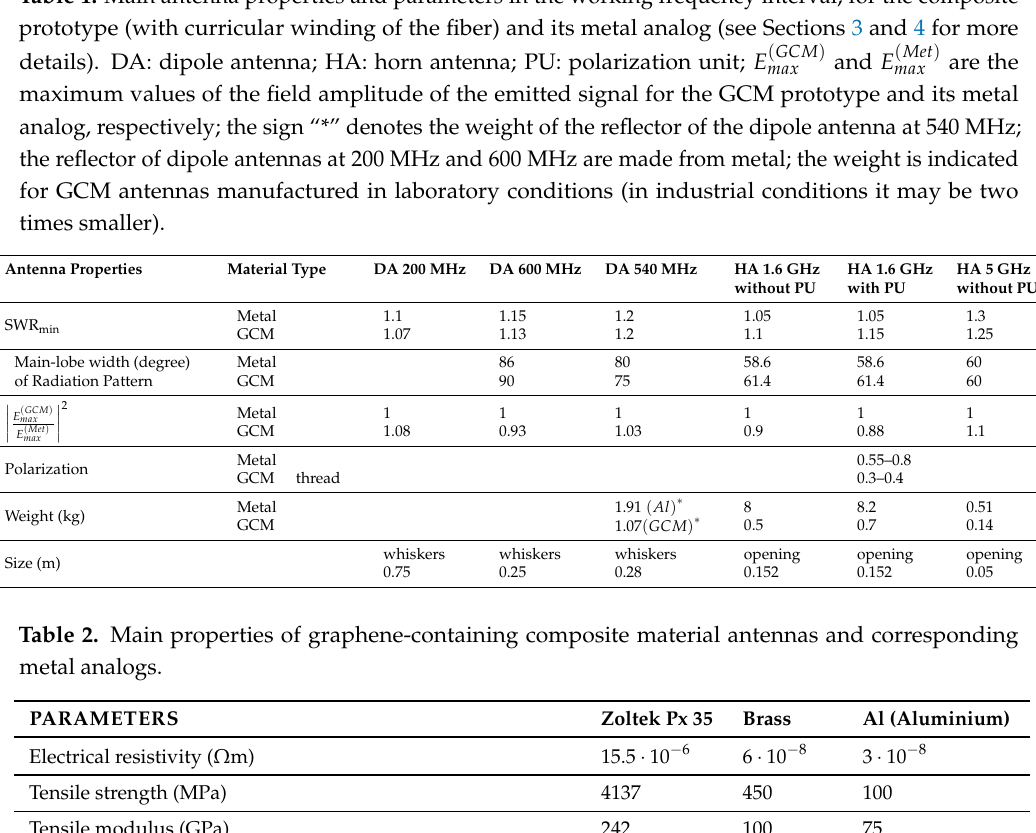
( GCM ) ( Met ) max and E max are the